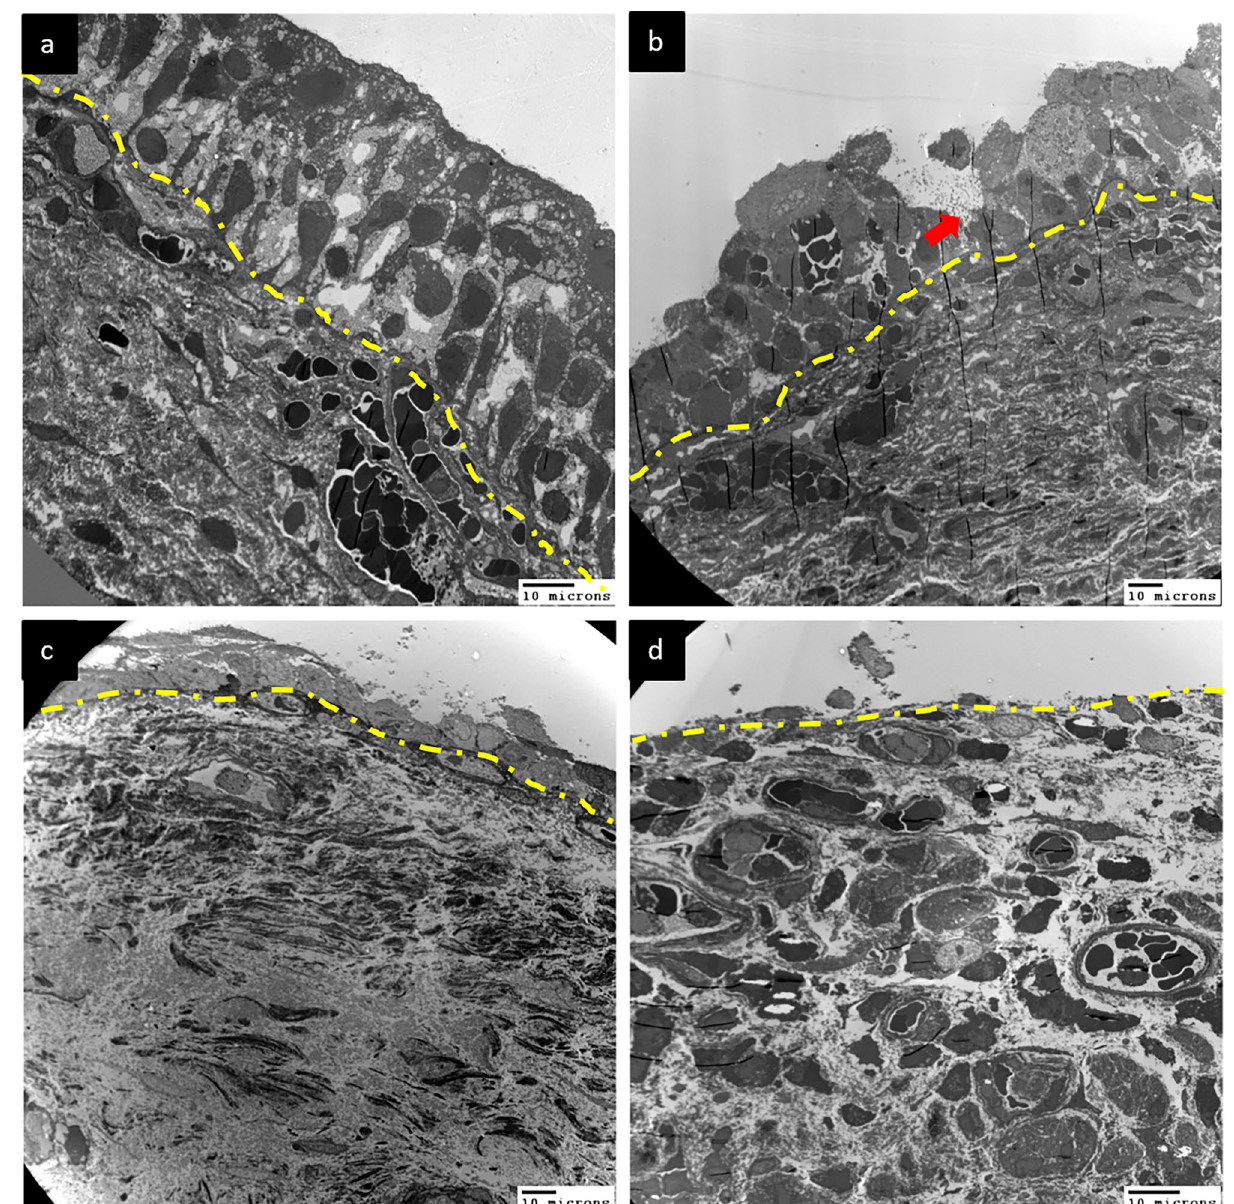
Figure 1. Transmission electron micrographs of the urothelium cell layer in interstitial cystitis/bladder pain syndrome (IC/BPS) patients with different grades of defect. ( a ) A sample of grade 0 (control subject) showing the normal 3–6 urothelial cell layers above the basement membrane (dotted line). ( b ) A sample of grade 1 from a IC/BPS patient showing a reduction in the number of cell layers, including modest denudation of umbrella cells (red arrows). ( c ) A grade 2 sample with only 2 or 3 urothelial cell layers remaining in most areas and more severe denudation of umbrella cells. ( d ) A grade 3 sample with almost complete loss of urothelial cells, resulting in a bare basement